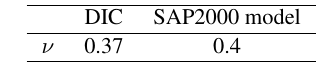
Table 3: Poisson’s ratio comparison for the test n.